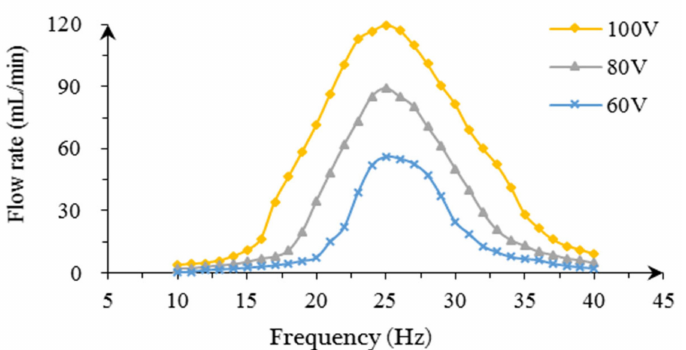
Figure 9. Curves of flow rate with